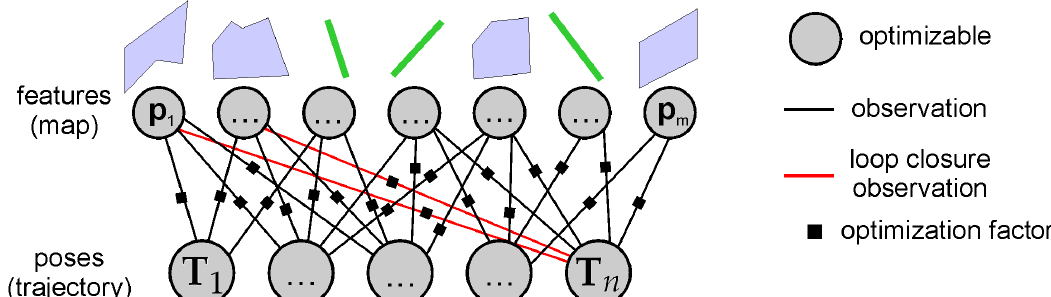
Figure 13. Global optimization based on map features involves optimization of the pose estimates ( T ) and features planes ( p ) using the pose-to-feature constraints. There are no pose-to-pose constraints and loop closure information is included directly by merging corresponding features from the re-visited